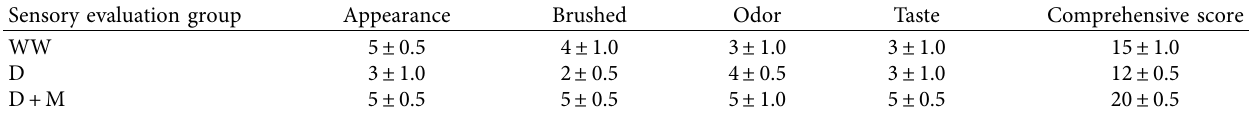
Table 4: Sensory evaluation of natto samples.